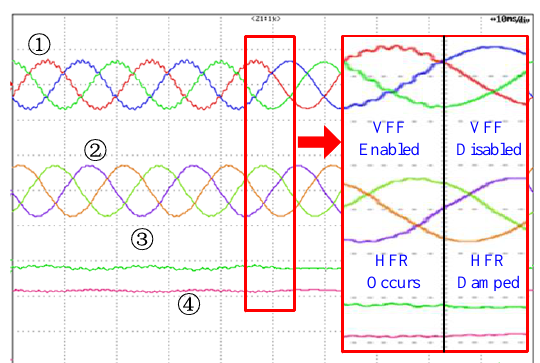
Figure 15. HFR damping for the VSC system ① V sabc (100 V/div), ② I abc (8 A/div), ③ P (1.5 kW/div), ④ Q (1.5 kVar/div).